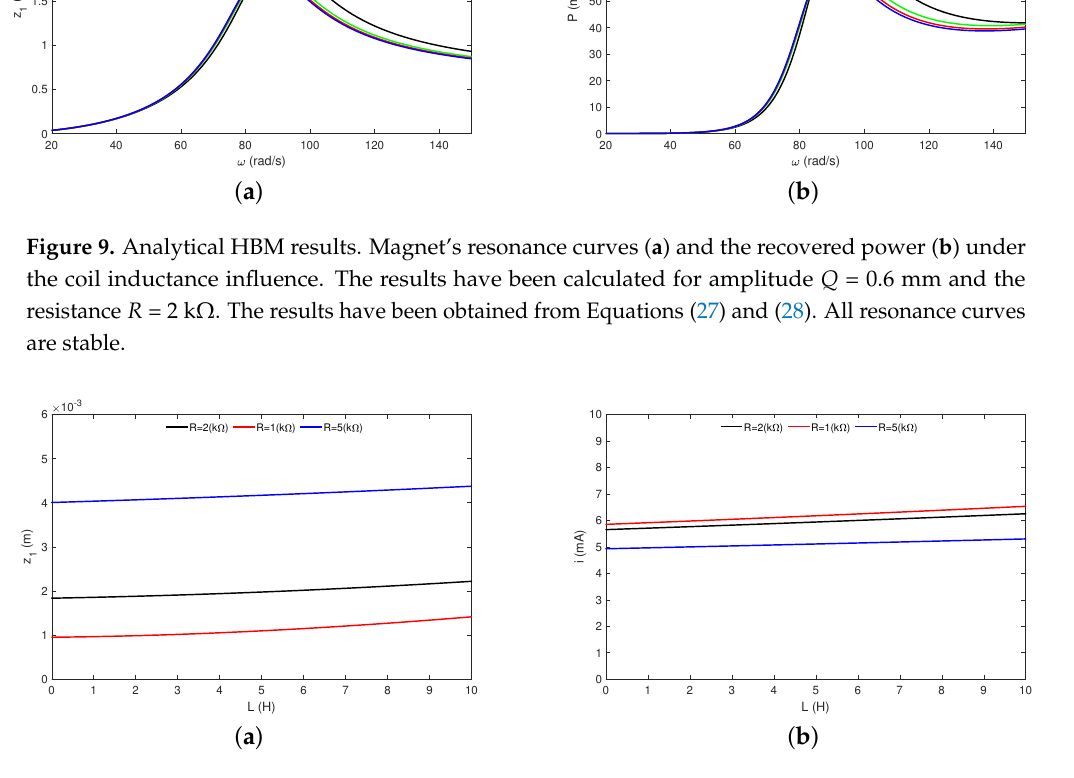
Figure 10. Influence of the coil inductance L on the magnet’s response ( a ) and the recovered current ( b ). The results have been obtained for frequency ω = 88 rad/s.